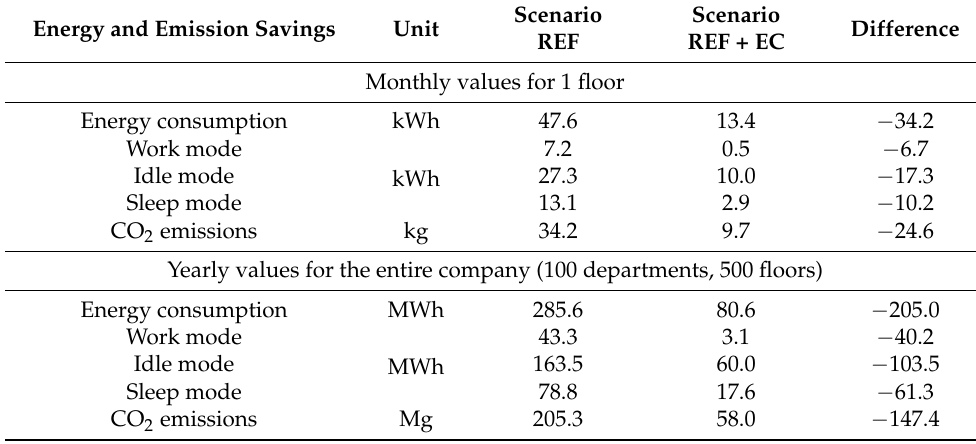
Table 9. Comparison of energy and carbon emission